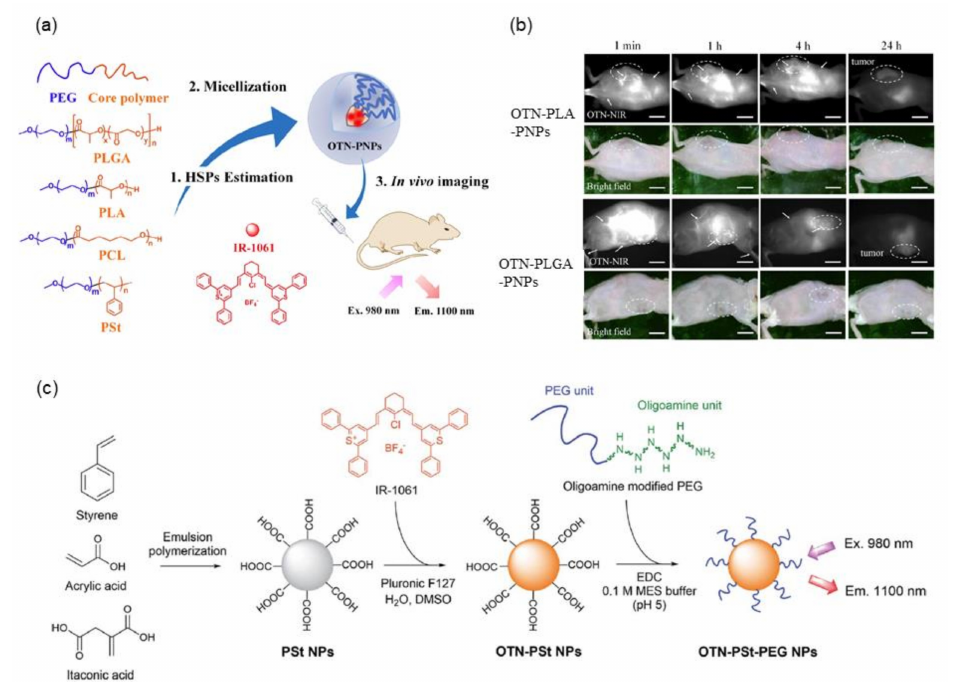
Figure 2. NIR dye-loaded luminescent polymeric micelles and solid nanoparticles. ( a ) Molecular structures of the compounds used for preparing OTN-polymeric nanoparticles (PNPs) and their schematics (Ex.: excitation; Em.: emission). ( b ) OTN-NIR fluorescence in vivo imaging of live